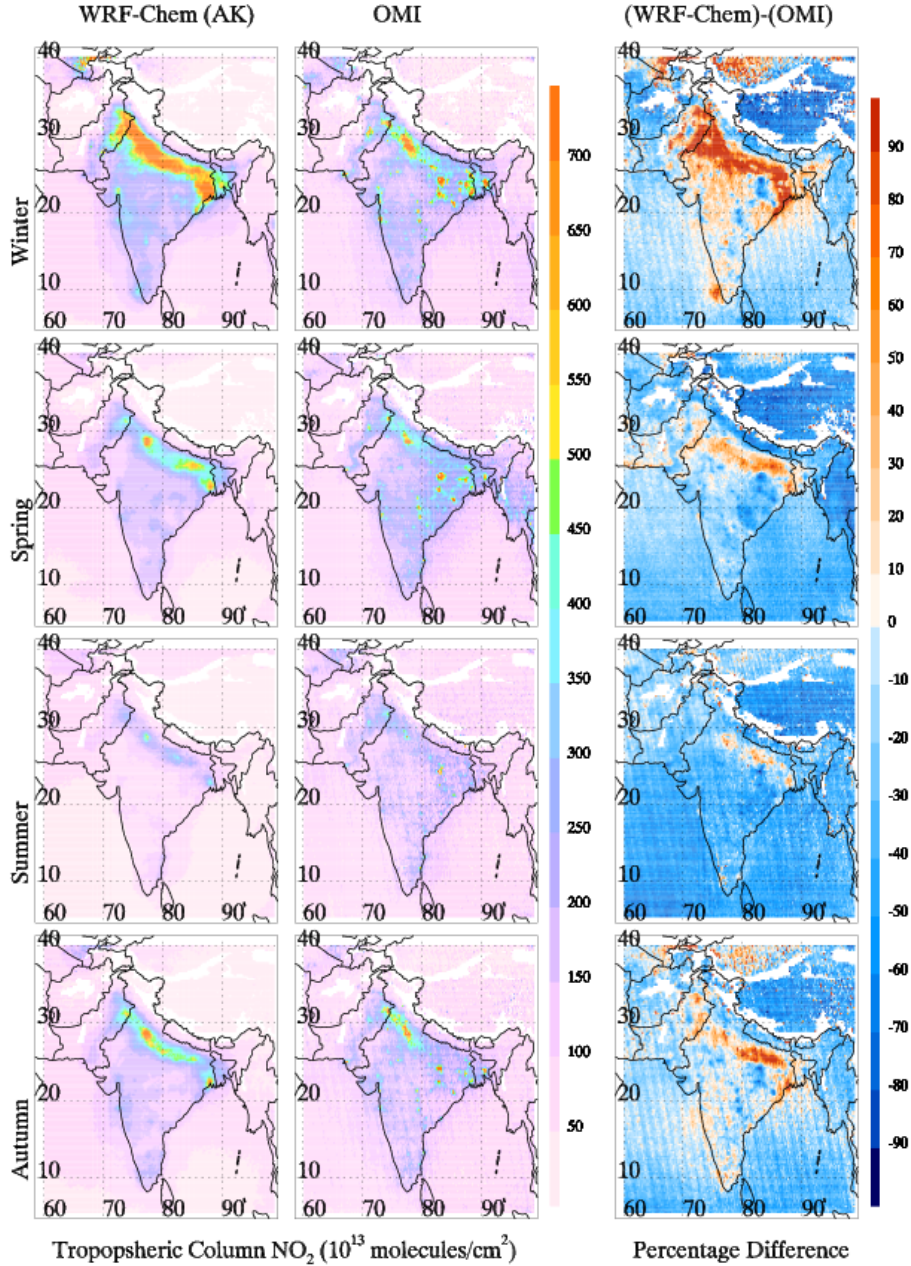
Fig. 13. Spatial distributions of WRF-Chem simulated and OMI- retrieved tropospheric column NO 2 during winter (DJF), spring (MAM), summer (JJA) and autumn (SON) 2008. Note that WRF-Chem profiles are smoothed with OMI averaging kernel before comparison. Both model and OMI data are averaged over a 0.25 ◦ × 0.25 ◦ grid.